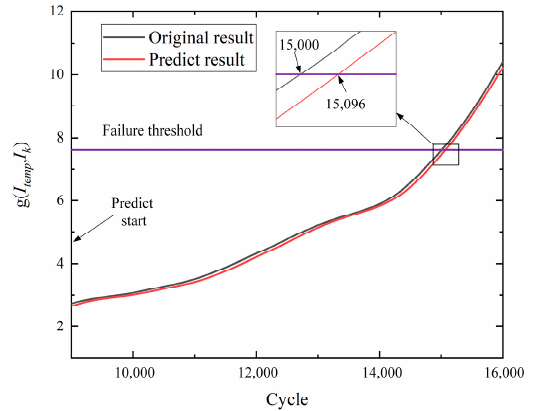
Figure 13. Prediction curve after filtered.